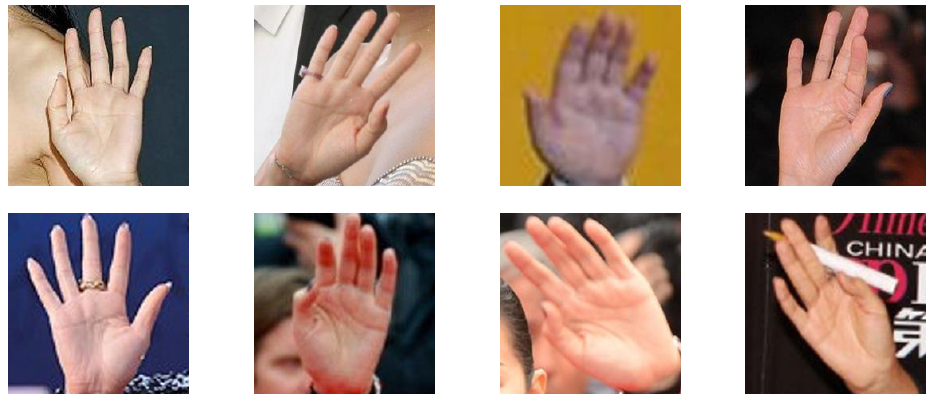
Figure 1. Palmprint samples with different types of interference information in the backgrounds